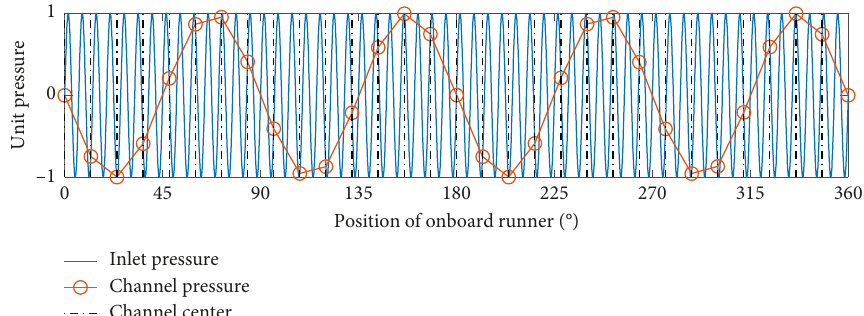
Figure 2: Instantaneous illustration of the DM4 excitation. A sinusoidal signal with 2 ∗ 28 periods is divided into 30 equal segments. The intersection line for each segment represents the pressure in each of the 30 runner channels. By plotting a curve through the intersection points, the overall pressure with 4 diametral modes appears.